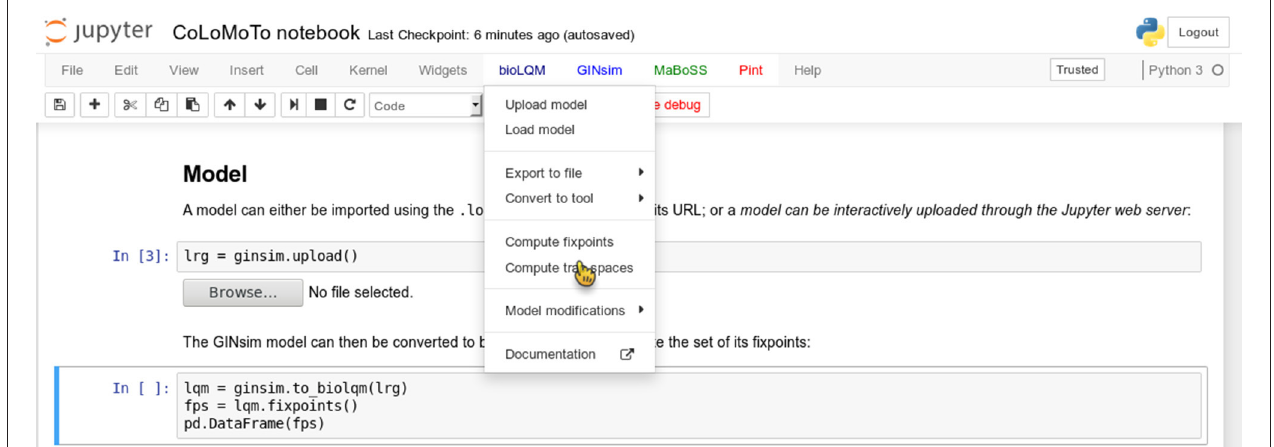
FIGURE 3 | Screenshot during a Jupyter notebook edition showing the menu of the BIOLQM tool.